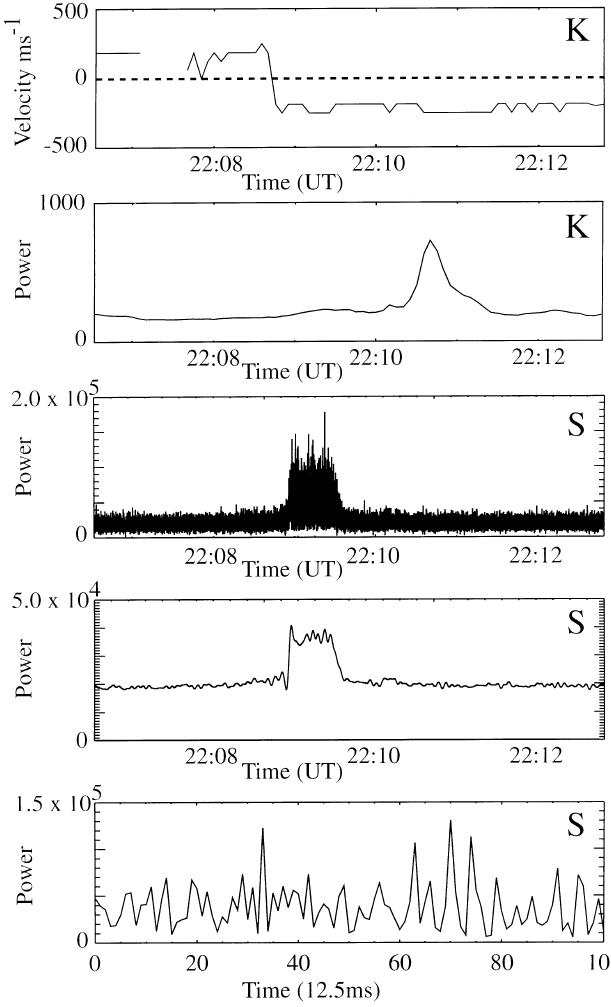
Fig. 5. FAST-COSC observations for 7 March 1997. From top to bottom the panels illustrate: the COSC determined irregularity phase speed measured at the Kiruna receiver, the COSC measured backscattered power, the 12.5-ms resolution slicer profile measured by the FAST-COSC experiment at Sodankyla¨ , the same time-series filtered to remove high-frequency components and a 100-point sample of data from within the scattering event, commencing at approx- imately